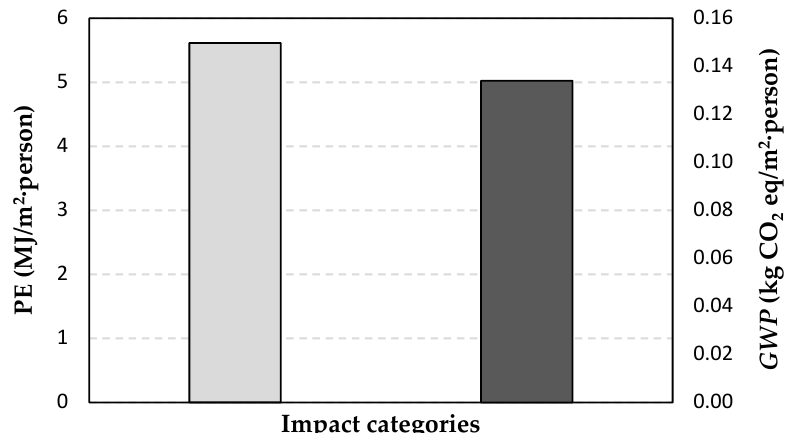
Appl. Sci. 2020 , 10 , x FOR PEER REVIEW Figure 4. Total primary energy (PE) and global warming potential (GWP) of the buildings analyzed.